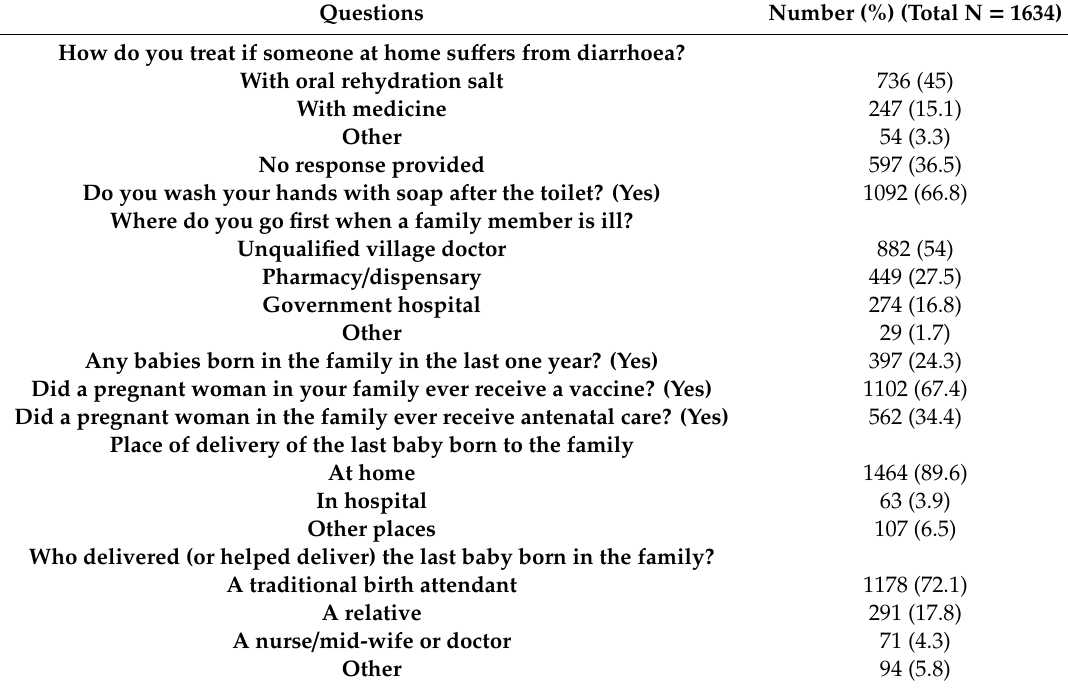
Table 4. Health literacy and access to health care among Rohingya refugees during their stay in Myanmar, as reported by primary respondents.